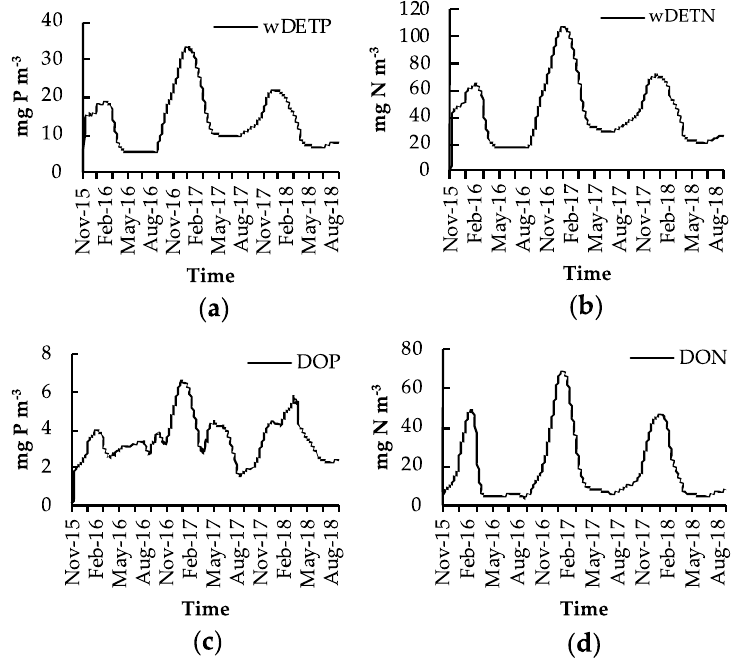
Figure 4. Seasonal changes in the calculated ( a ) detritus-P (waterDET-P), ( b ) detritus N (waterDET-N), ( c ) dissolved organic P (DOP), and ( d ) dissolved organic N (DON) in the ATR-deployed area.